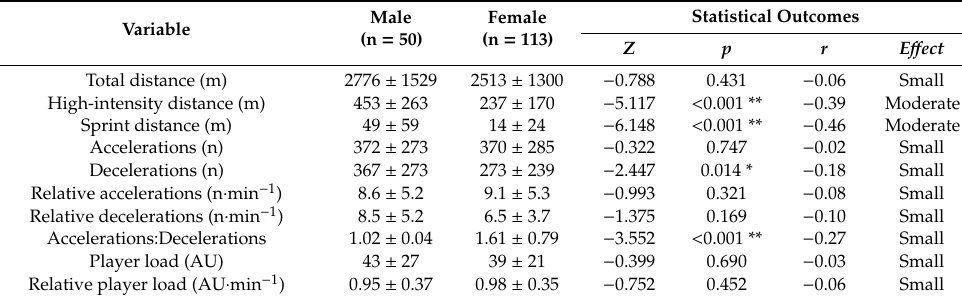
Table 2. The external loads (mean ± standard deviation) encountered by elite, junior male and female players during competition.